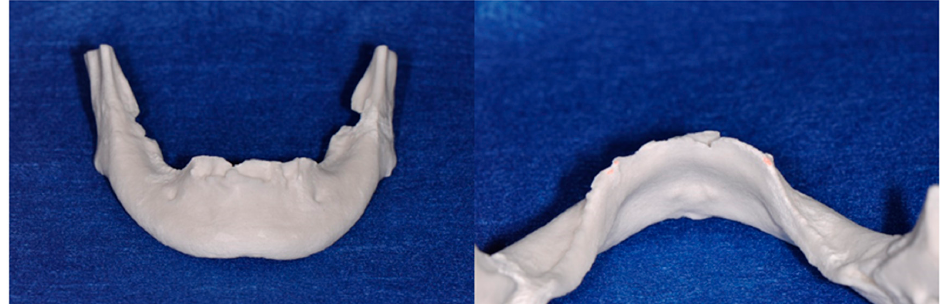
Figure 4. The plaster model of mandible fabricating by a three-dimensional printer on the CT data. Front ( Left ) and rear ( Right )